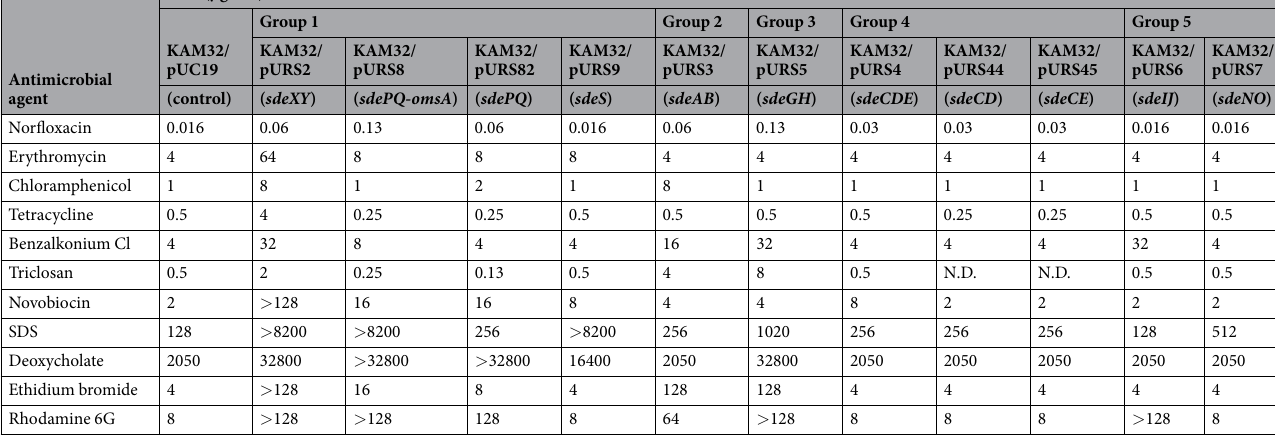
Table 1. MICs of antimicrobial agents in E . coli KAM32 harboring each RND-type efflux pump. N.D.; not determined.